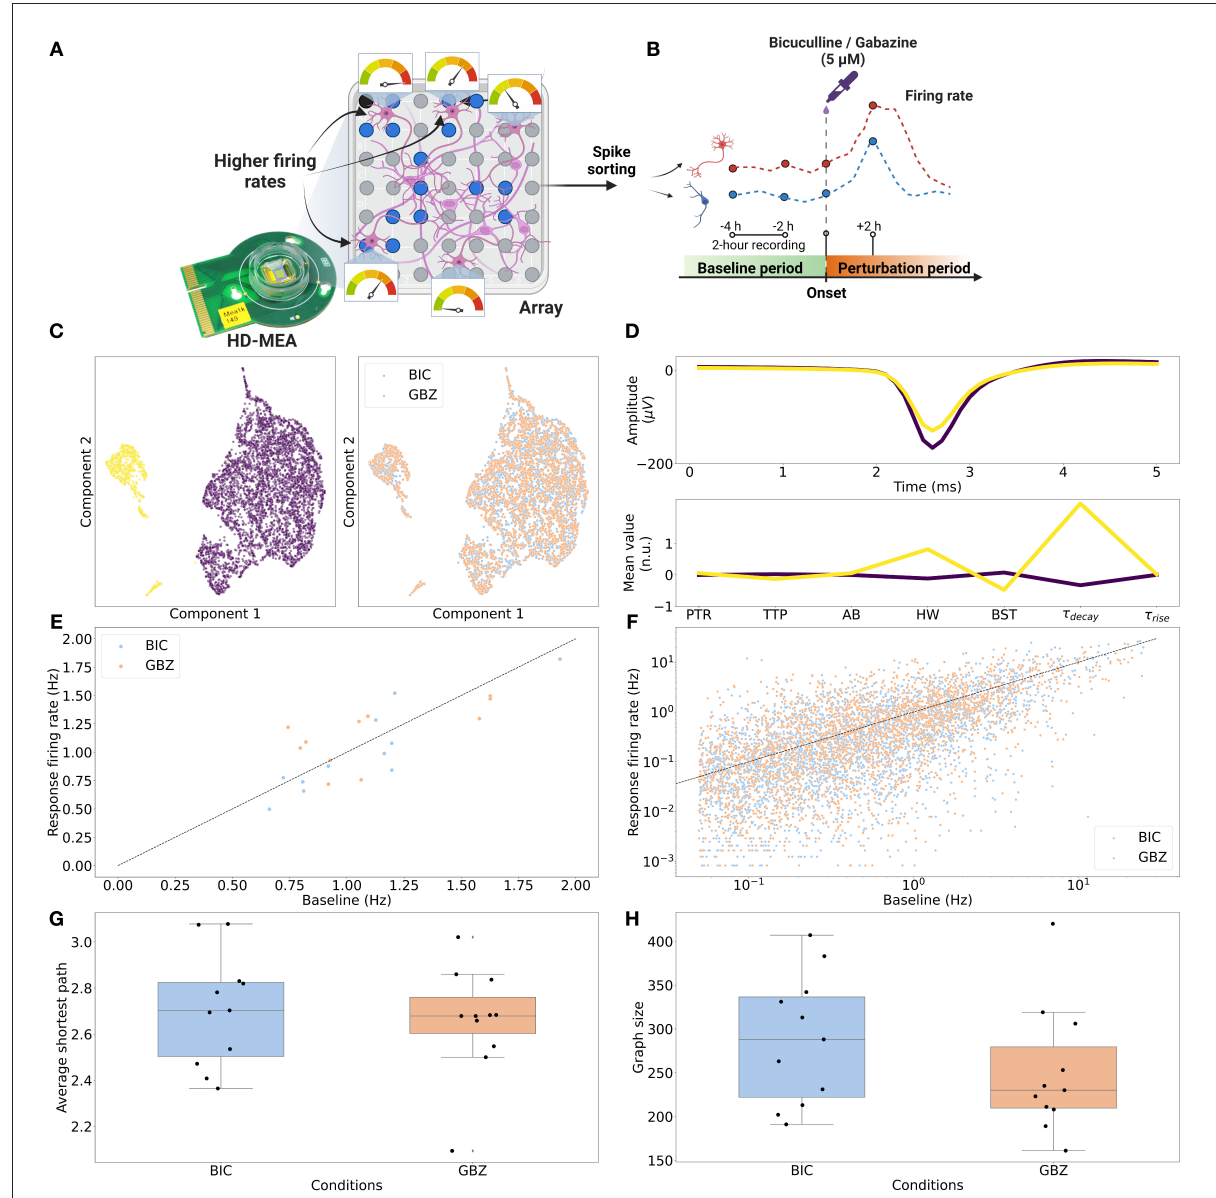
FIGURE5 Firing rate changes and graph characterization of the test dataset. (A) HD-MEA recordings were acquired prioritizing electrodes detecting higher firing rates across the entire sensing area. (B) Gabazine (GBZ) (5 µ M; 11 recordings) and Bicuculline (BIC) (5 µ M; 11 recordings) were applied to measure immediate perturbation responses (Task 1. < +6 h after the onset). (C) (Left) UMAP-reduced single-neuron features were best clustered ( k -means clustering) with k = 2 based on the silhouette score. (Right) Between two perturbation conditions, there was no obvious difference in the distribution of the features. (D) (Top) The averaged waveform for each cluster. (Bottom) Between the two clusters, τ decay showed the largest difference in the average normalized (standard scaled) value. (E) The application of perturbation (BIC and GBZ) resulted in both increase and decrease in population firing rates. Fold-changes ( 1 fch ) in population firing rates for BIC showed the mean of 0.932 ± 0.157 ( µ ± σ ) and 1.072 ± 0.273 for GBZ. (F) Differential fold-change of single-neuron firing rates ( 1 fch ′ ) showed a large variance with the mean of 0.247 ± 2.233 and 0.597 ± 4.132 for BIC and GBZ, respectively. (G) PCC FC graphs derived from these networks exhibited average shortest paths of 2.711 ± 0.244 (BIC) and 2.669 ± 0.242 (GBZ). (H) Networks contained on average 289 ± 74.318 neurons for BIC and 253.455 ± 76.764 neurons for